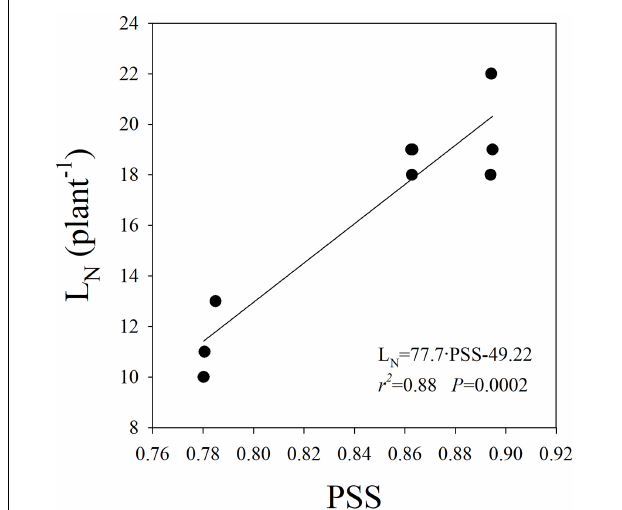
FIGURE 4 | Linear relationship between leaf number (L N ) and phytochrome photostationary state (PSS) in romaine lettuce. A linear regression was fitted to data from three light treatments and three replications per